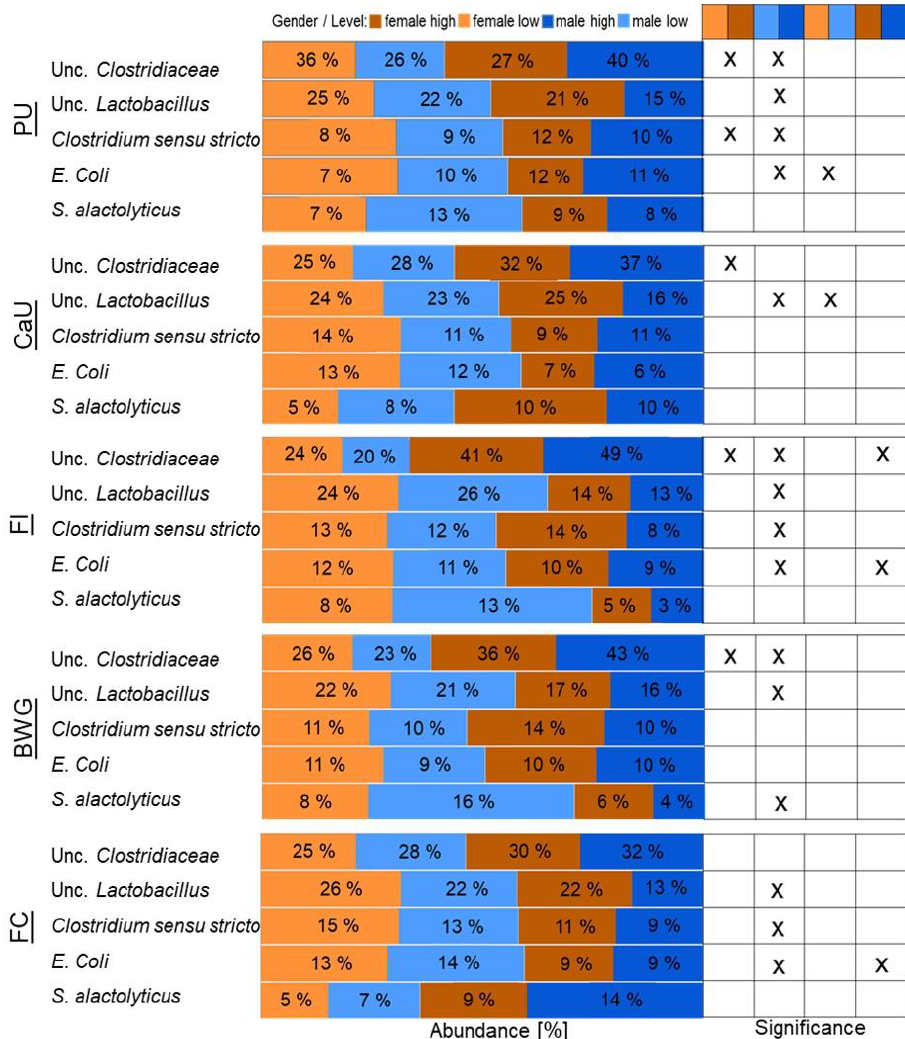
Figure 3. Abundance variation of the five operational taxonomic units (OTUs) that contribute to 70% of total bacterial community of females and males considering phosphorous utilization (PU), calcium utilization (CaU), feed intake (FI), body weight gain (BWG), and feed conversion (FC). Statistical significances between the groups are depicted on the graph ( p -value < 0.05).